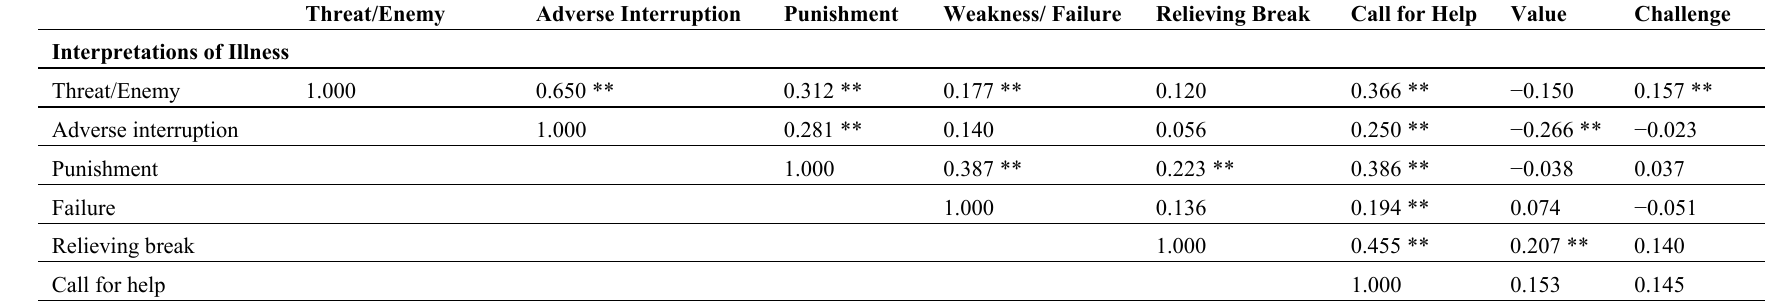
Table 5. Interpretations of illness and their correlations with life Satisfaction, escape from illness, and aspects of